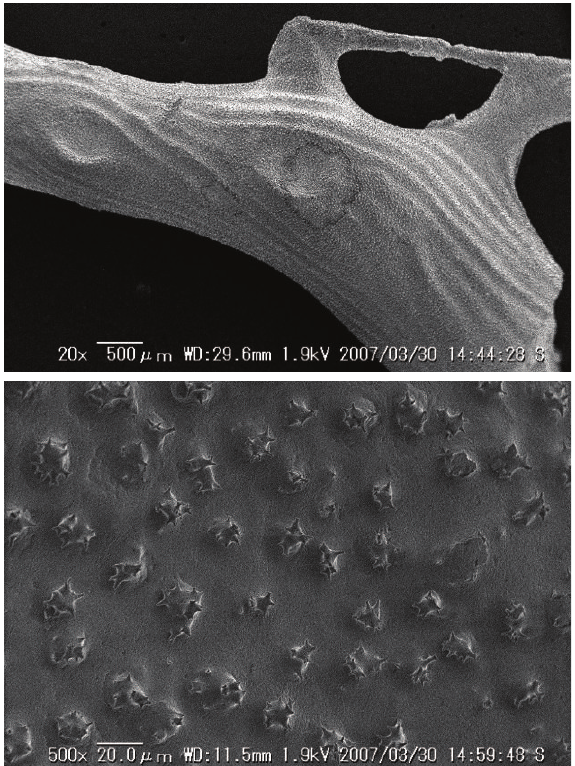
Figure 8: SEM image of axis surface of Paracorallium japonicum ;